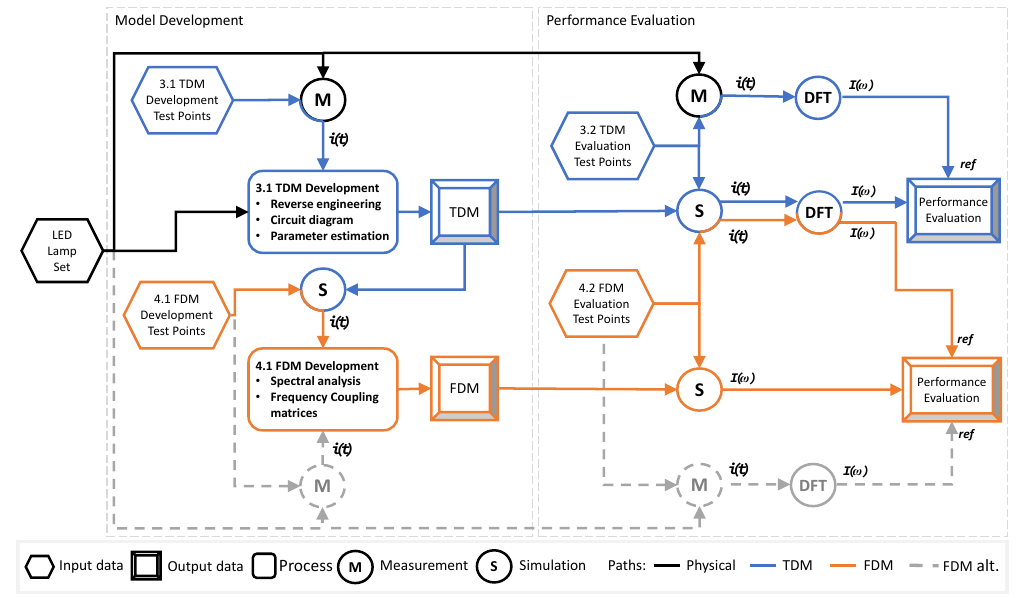
Figure 1. Rationale of the development and performance evaluation of time-domain models (TDMs) and frequency-domain models (FDMs). LED = light emitting